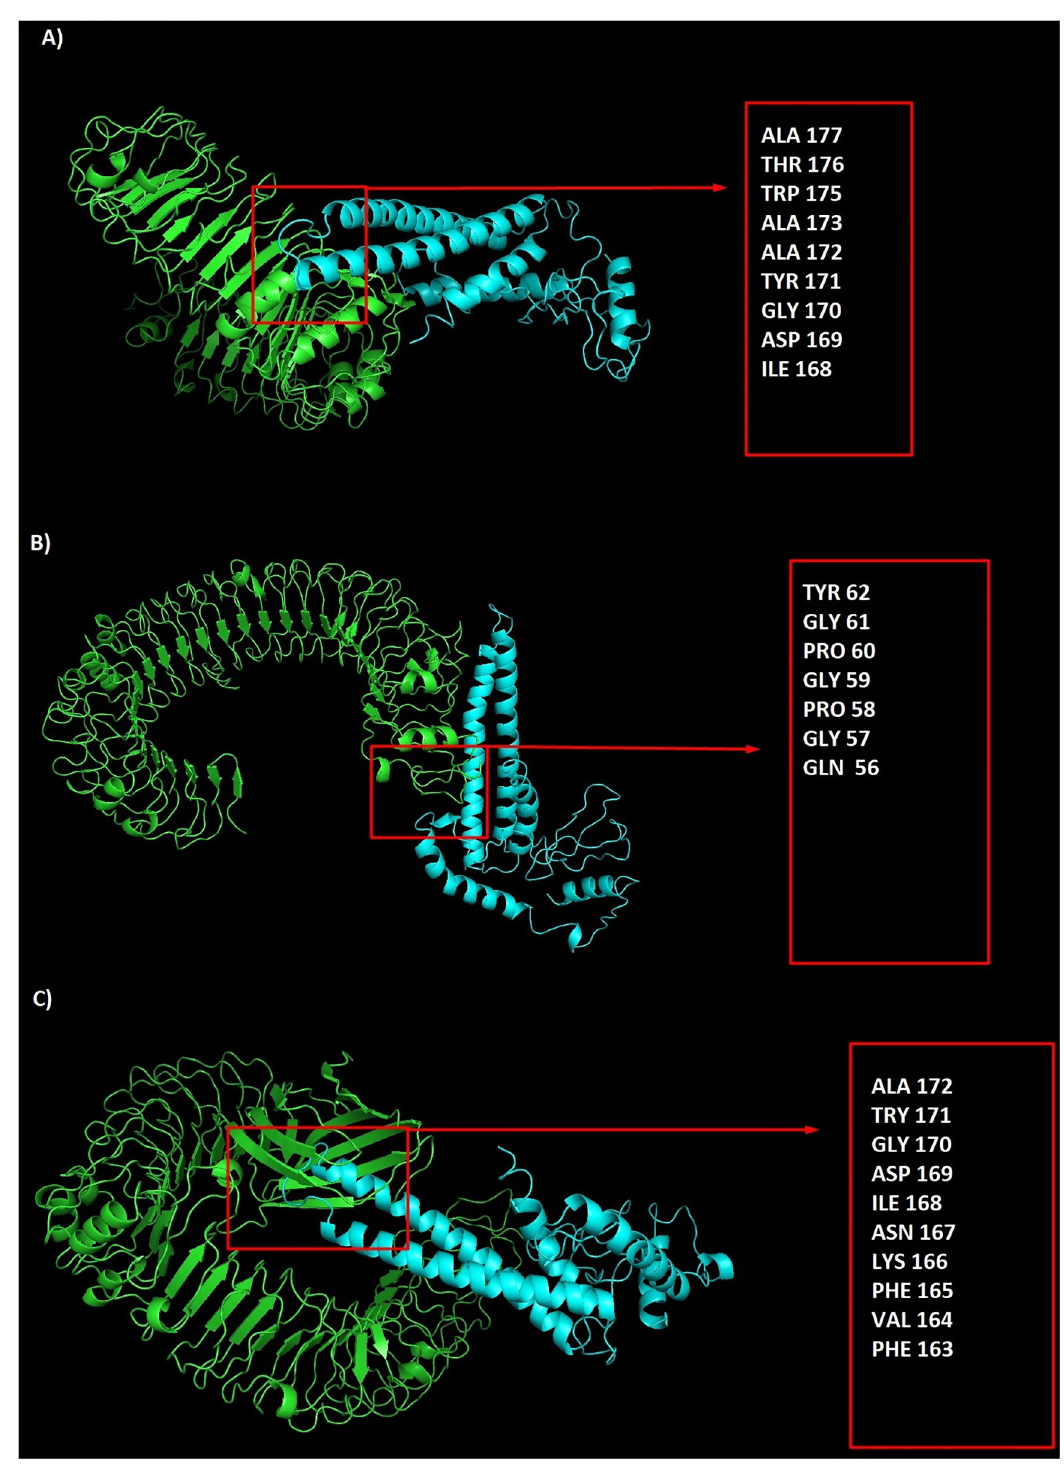
Fig 3. The peptide-protein docking between the designed construct and TLRs 2, 3 and 4: A) designed construct-TLR2 complex with participated residues in interaction, B) designed construct-TLR3 complex with participated residues in interaction, C) designed construct-TLR4 complex with participated residues in interaction.